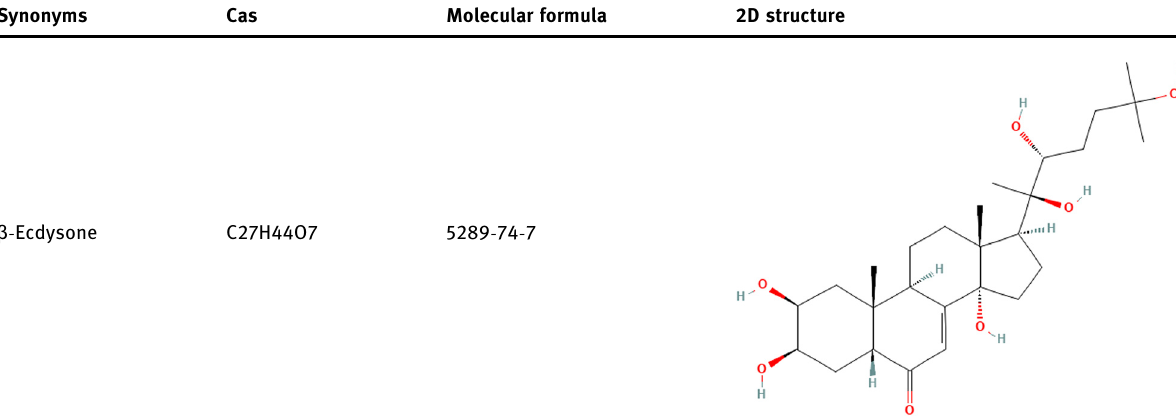
Table 2: The chemical structure of β - ecdysone